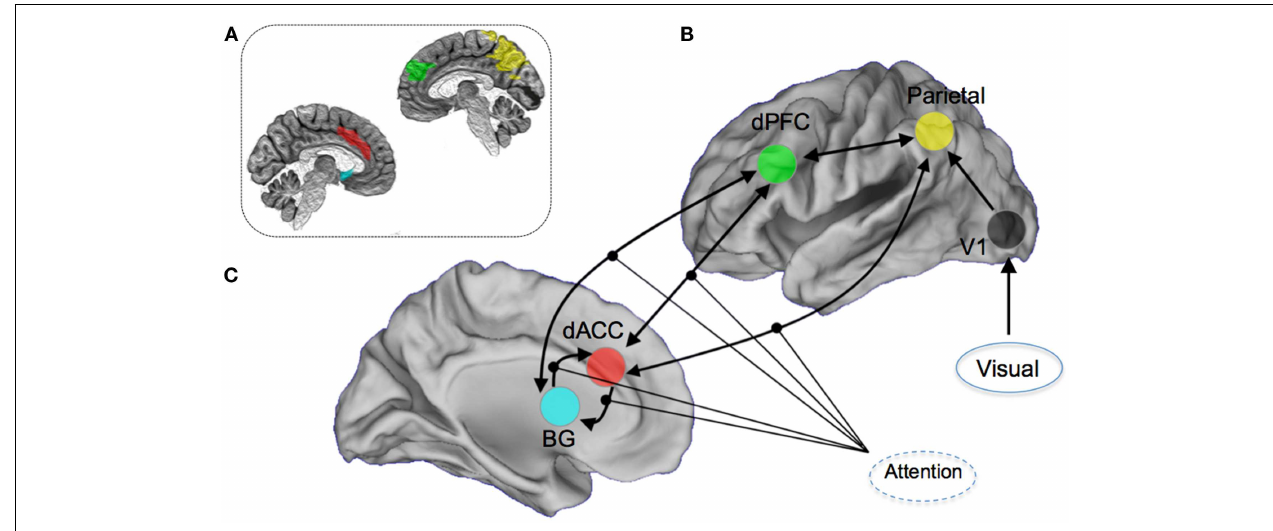
through the primary visual cortex. For the dACC–BG pathway, the bilateral endogenous connection itself was permuted.The inset image provides a schematic depiction (on a mid-sagittal slices) of the anatomical definitions used in summarizing regional activity for the DCM modeling.The color-coding of the regions of interest is approximately